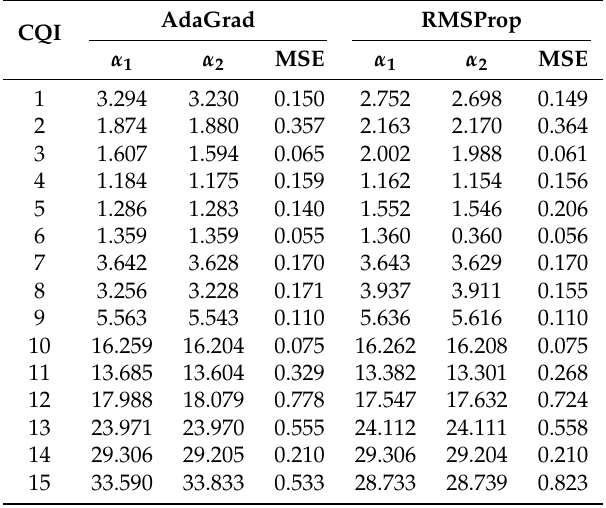
) in 5G CDL-A SISO. , α ∗ 2 1